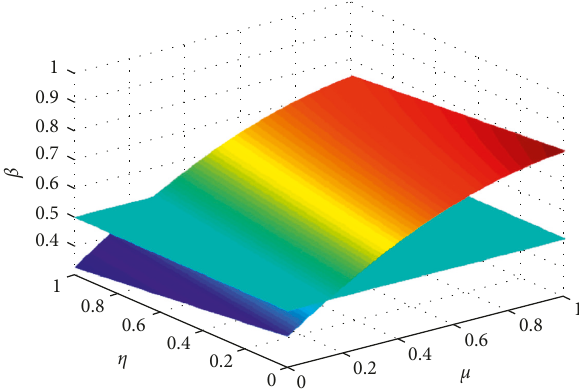
Figure 4: Effects of coefficients of converting conflicts to benefit and the loss caused by conflicts on the coefficient of benefit